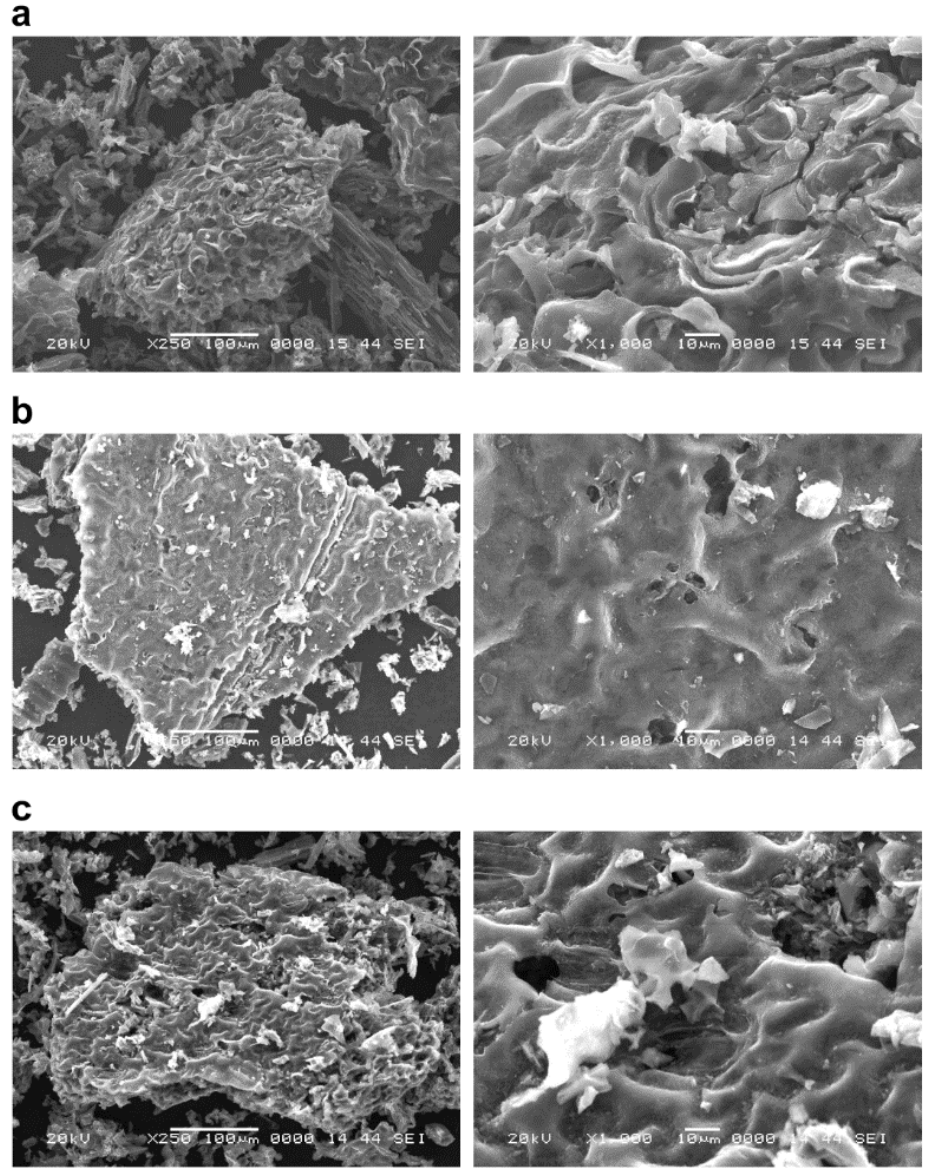
Figure 3. The surface structure of NaOH-modified P. vittata biochar by SEM observation. Left column: Magnification 250×; Right column: Magnification 1000×; ( a ) Pyrolysis temperature: 600 °C; ( b ) Pyrolysis temperature: 800 °C; ( c ) Pyrolysis temperature: 1200 °C.